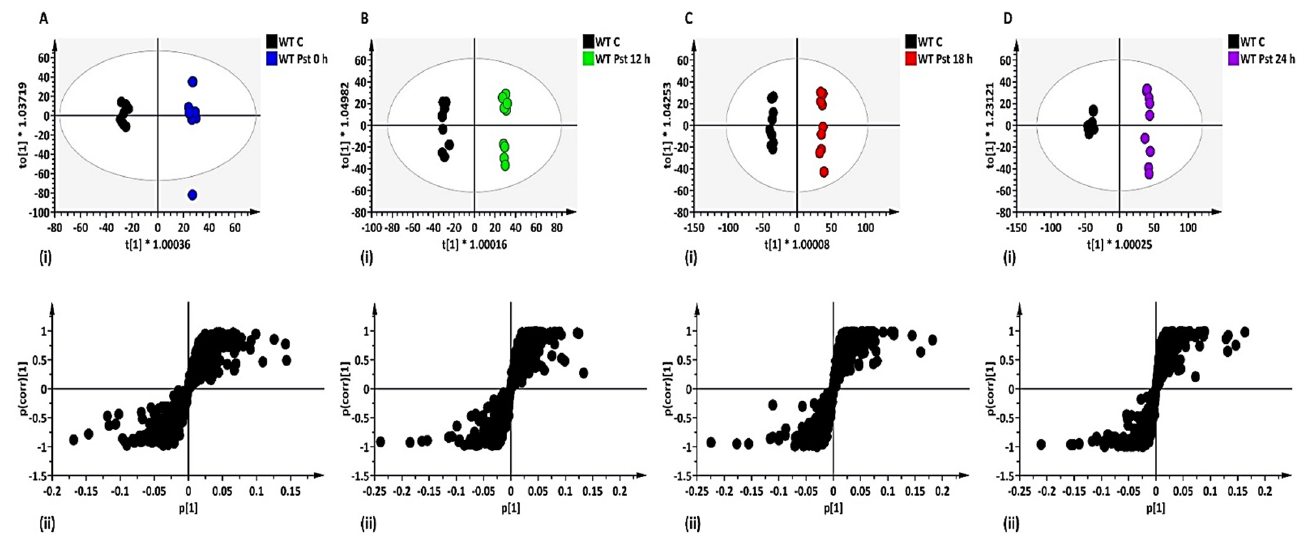
Figure 1. Orthogonal projection to latent structures discriminant analysis (OPLS-DA) modelling of Arabidopsis WT leaf extracts (ESI (–) data). ( A – D ) ( i ) represent OPLS-DA score plots showing clear separation between control vs. LPS Pst treatment after 0, 12, 18, and 24 h, respectively. ( A – D ) ( ii ) represent OPLS-DA loading S-plots showing the discriminant features (ions) responsible for the sample grouping observed in ( A – D ) ( i ). The OPLS-DA model parameters were: ( A ) R 2 X = 46.2%/Q 2 = 97.4%, ( B ) R 2 X = 53.6%/Q 2 = 98.3%, ( C ) R 2 X = 60.9%/Q 2 = 98.9%, ( D ) R 2 X = 64.2%/Q 2 = 98.9%, respec- tively. The variables in the top right quadrants of the S-plots correlated positively to the treatment. Selected discriminant ions for downstream metabolite identifications were based of a correlation [ p (corr)] of ≥ 0.5 and covariance of (p1) ≥ 0.05. The equivalent set of figures for the ESI (+) mode is presented as Figure S3.